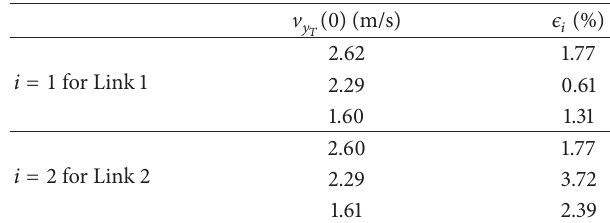
Table 5: Relative error between the experimental and simulation results for penetration